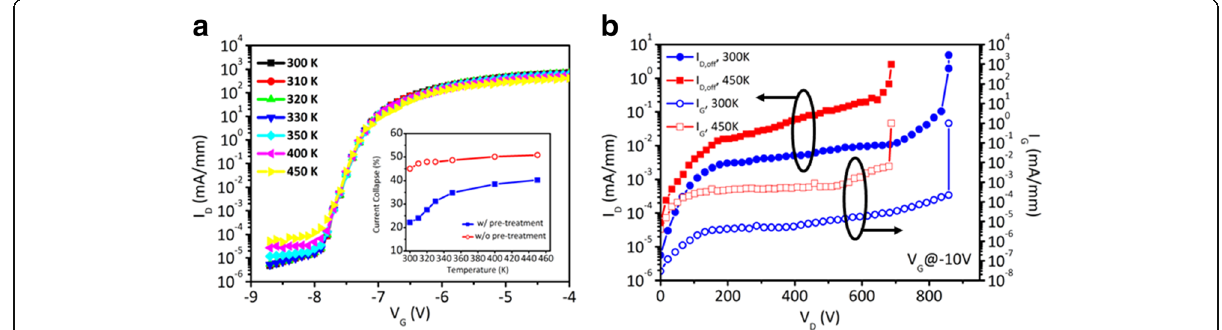
Fig. 5 a Temperature dependent I DS - V GS of plasma pre-treated HEMT. The inset shows the current collapse with increased temperature. b The temperature dependent BV measurement of plasma pre-treated HEMT. The void lines show the temperature dependent I GS of plasma pre-treated